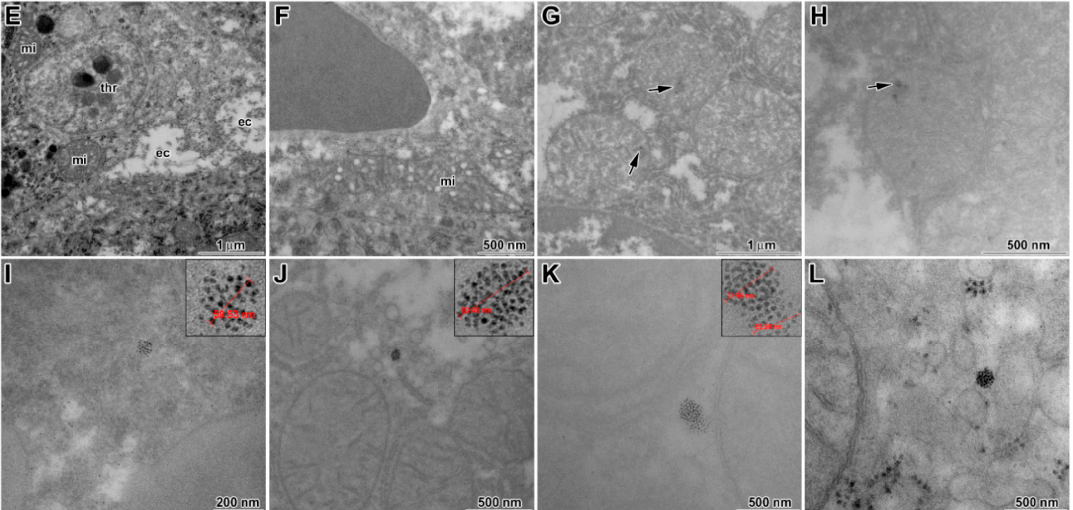
Figure 4. Ultracellular changes in liver following of six weeks exposure to CdO nanoparticles: ( A ) hepatocytes after treatment without pathological changes; ( B ) hepatocytes after treatment with altered ultrastructure showing severe signs of degeneration; ( C ) epithelial cells of bile duct with signs of hydropic degeneration; ( D ) microvilli (arrows) of hepatocyte in Disse’s space, cytoplasmic parts of edematous endothelial cells, erythrocyte in sinusoid capillary; ( E ) mitochondria in Kupffer cell with unusual arrangement of mitochondrial cristae, cytoplasmic parts of edematous endothelial cells, thrombocyte in lumen; ( F ) mitochondria in Kupffer cell with unusual arrangement of mitochondrial cristae; ( G , H ) mitochondria in hepatocytes with observed cadmium nanoparticles (arrows) enveloped in denser mitochondrial matrix; and ( I – L ) cadmium nanoparticles freely in cytoplasm of hepatocytes: ( I – K ) non-contrasted sections; and ( L ) contrasted section. ec, endothelial cells; ery, erythrocyte; hc, hepatocyte; mi, mitochondria; thr, thrombocyte.